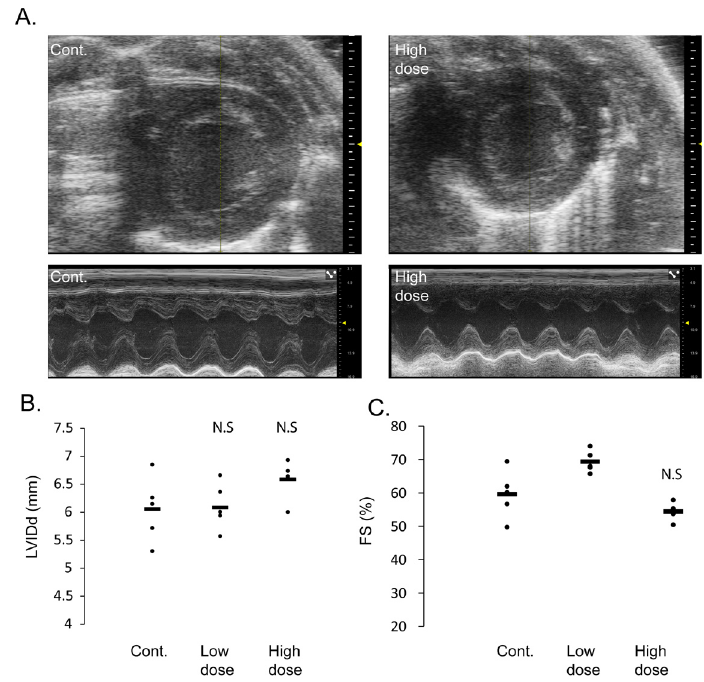
Figure 2. Rats injected with AAV9-cTnT-eGFP have normal cardiac dimensions and function. A . Representative echocardiographic images in two-dimensional short axis view (top) and M-mode (bottom) magnification, showing normal cardiac dimensions, wall thickness and contractile function even in rats injected with ‘high dose’ AAV9-cTnT-eGFP (right). Control saline injected rat heart is shown on the left. B . Echocardiographic measurements of left ventricular internal diameter in end diastole (LVIDd) showing no significant changes between rats injected with ‘high dose’ or ‘low dose’ AAV9-cTnT-eGFP and control saline injected rats. Black bars show average and each dot represent measurement from one rat. N.S = not statistically significant from control by Student t-test. C . Echocardiographic measurements of left ventricular fractional shortening (FS%) showing no decrement in cardiac function between rats injected with ‘high dose’ or ‘low dose’ AAV9- cTnT-eGFP and control saline injected rats. Black bars show average and each dot represent measurement from one rat. N.S = not statistically significant from control by Student t